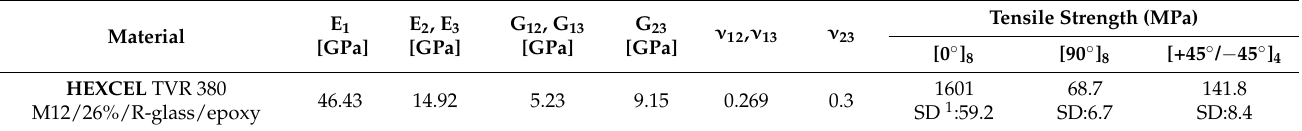
Table 2. Mechanical properties of composite